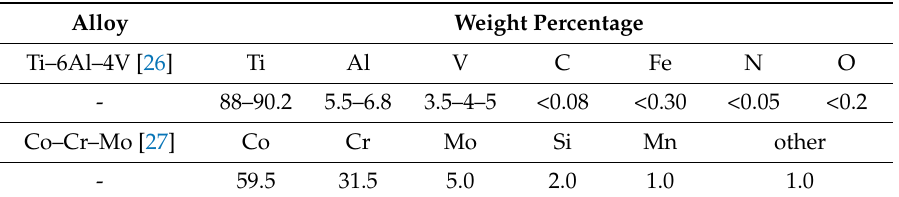
Table 2. Nominal chemical composition of the two alloys.